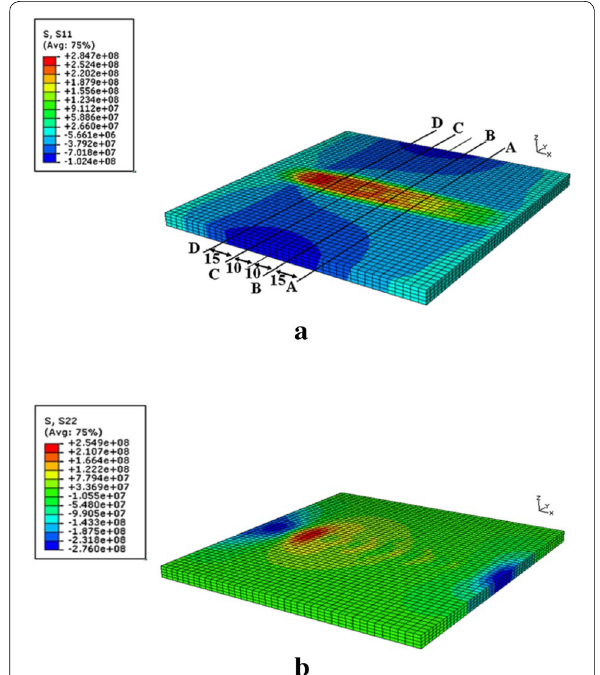
Figure 19 Distribution of the stress across the workpiece: ( a ) S11 Stress in 1 direction, ( b ) stress in 2 direction